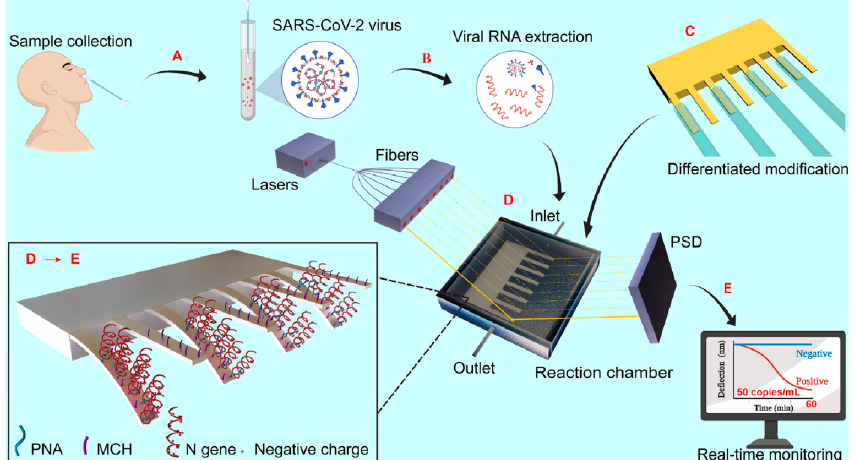
Figure 9. Schematic of the nanomechanical method of SARS-CoV-2 detection from sampling to diagnosis. ( A ) Sample collection from infected individuals; ( B ) RNA extraction of SARS-CoV-2; ( C ) differential modification of microcantilever array with PNA. Four microcantilevers in an array were functionalized with PNA, and the other four were used for in situ comparison. ( D ) Detecting with nanomechanical devices. Eight semiconductor lasers sequentially emitted a stable beam focused on the tip of each microcantilever in the array, while a position-sensitive detector (PSD) was responsible for monitoring the deflection of each microcantilever in real time by measuring the movement of the reflected light. ( E ) Early diagnosis of COVID-19 within 60 min [137].